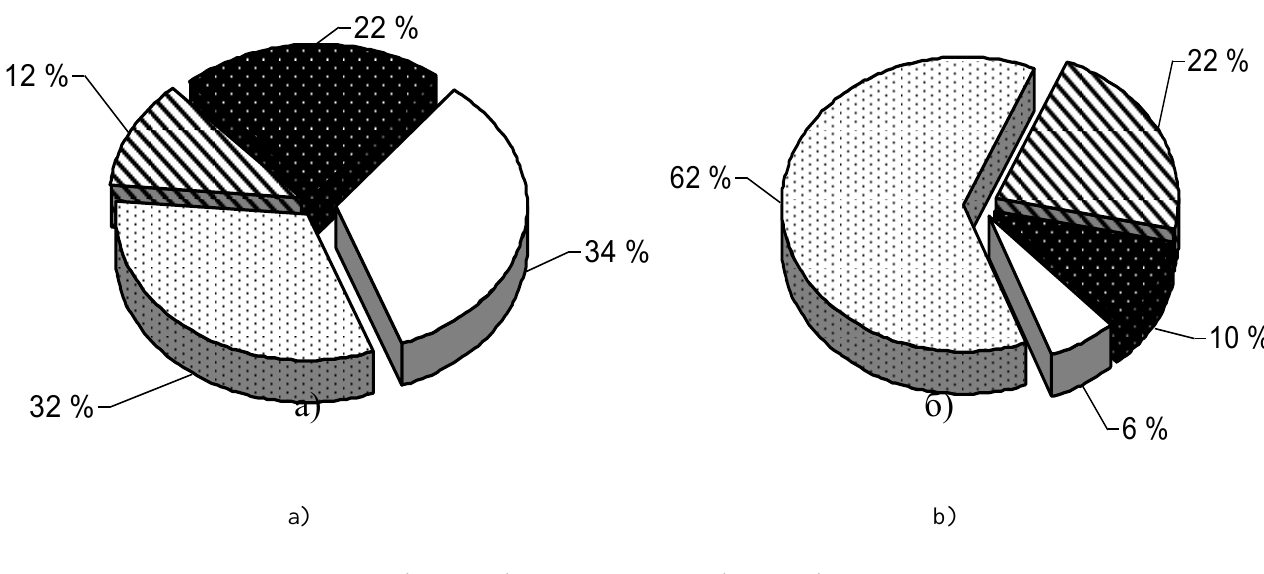
Fig.2. Application of psychological training means in training process of tennis players of different class (by expert’ data n=24): а)sportsmen of 14-15 years old age; b) elite